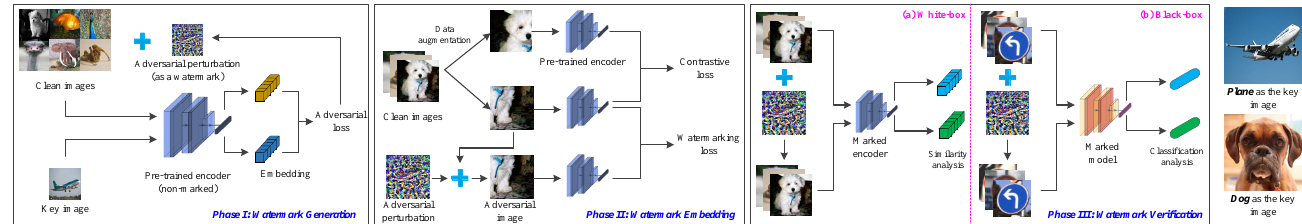
Figure 1. General framework for the proposed method. We use the same dataset for Phase I, Phase II and Phase III ( a ) so that the watermark can be successfully embedded into E θ while avoiding degrading the encoding performance of the encoder. In Phase II, each clean image is augmented into two images, from which only one randomly selected image was used for generating the corresponding adversarial image that will be used for watermark